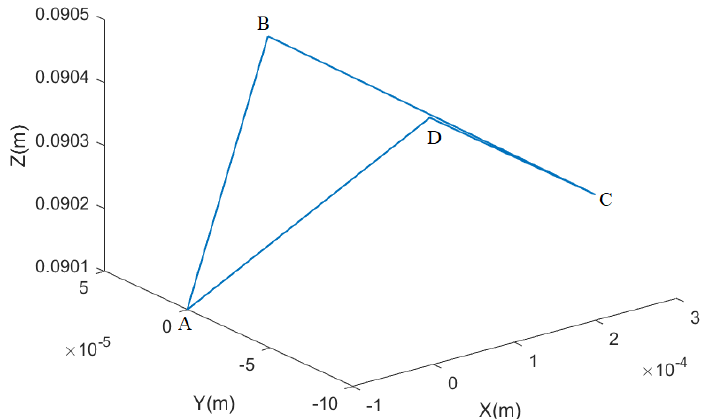
Figure 6. Trajectory 1 of the mobile platform of the SPR.